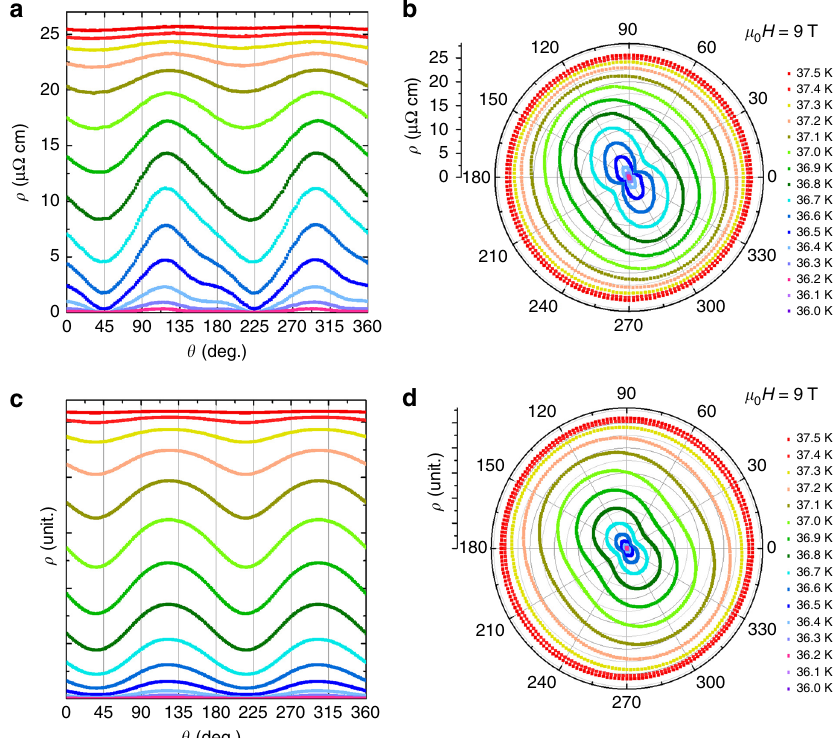
Fig. 2 Experimental and theoretical angular dependence IMR. Experimental ( a ) and theoretical ( c ) values of the angular dependence of the IMR, and respective polar plots of IMR experimental ( b ) and theoretical ( d ) values, at various temperatures for the applied magnetic fi eld of 9 T for which the experimental values were obtained using the Corbino disk measurement con fi guration. Theoretical values correspond to the model with three components with the symmetries s ± , d x 2 (cid:1) y 2 and d